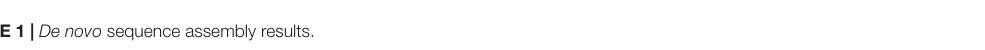
FIGURE 1 | The plant material of C. dichrum . (A) C. dichrum leaves. (B) C. dichrum flower bud. (C) C. dichrum blooming flower.